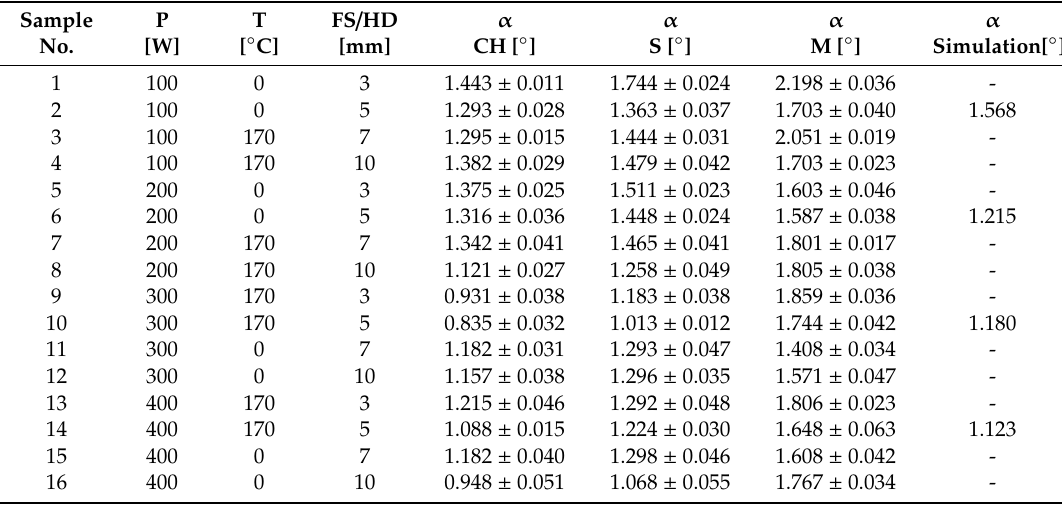
Table 4. Design of experiment (DoE) matrix and values of curling angle α for each strategy and simulation.